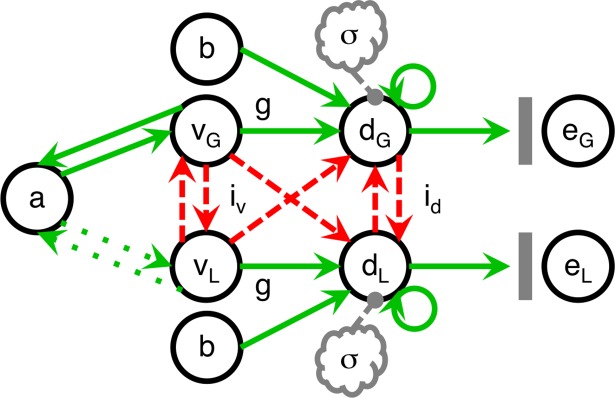
The supralinear subtractive competing-accumulator (SSCA) model.The SSCA model builds upon the SCA model with the intention of approximating the net effects of the addition of an attentional module that selectively modulates value signals. The positive-feedback loops that are consequently formed generate disproportionate amplification of value signals that are already greater in magnitude, thus promoting “winner-take-all” processing [32]. This schematic only depicts a positive-feedback loop at the level of value signals to adhere more closely to the parsimonious implementation used here with a static supralinear power law requiring only one free parameter, a. However, also plausible are loops at the next level bridging decision-making signals and attentional processes either with or without intermediate value signals. The contrast between solid and dotted green lines symbolizes the asymmetry in the positive-feedback loop’s impact on each alternative’s representation. As time progresses, there is an increasingly higher probability of attention being directed at the alternative with greater value, which is denoted by the G subscript, rather than the alternative with lesser value, which is denoted by the L subscript.